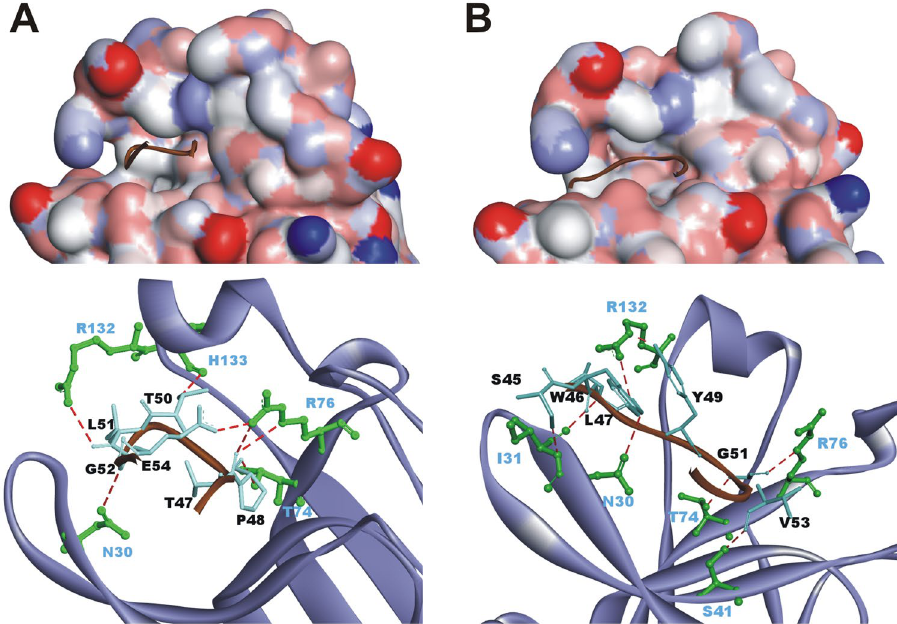
Figure 2. Computational analysis of EphA2-EphrinA1 mutant interaction. Overview (top) and the detailed intermolecular H-bond networks (bottom) between the inserting-loop and the groove of EphA2. The interaction between EM1 ( A ), or EM2 ( B ) and EphA2 was obtained by protein-protein docking analysis. Protein structure is shown as surface and/or ribbon model. The interacting residues of EphrinA1 variant and EphA2 are shown in sticks and ball-and-sticks, respectively, the H-bonds are shown in dashed line